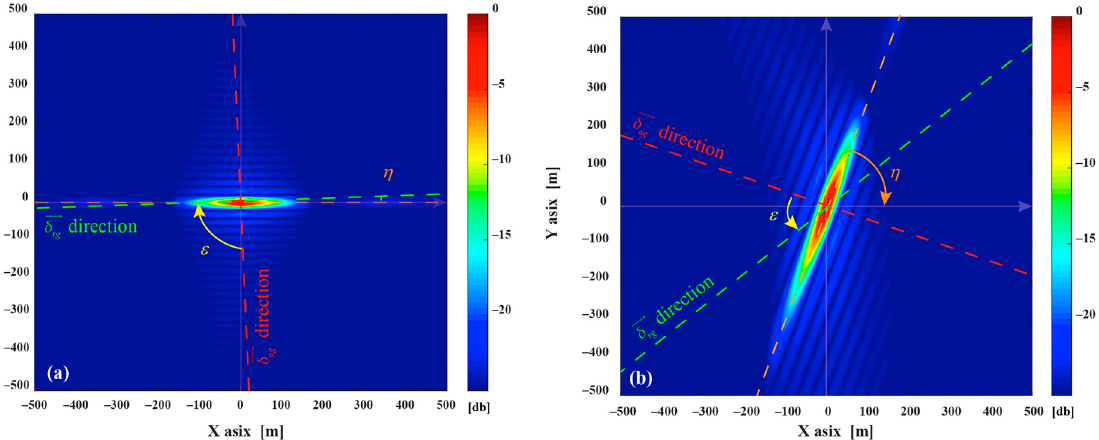
Figure 3. Simulated single-satellite Point Spread Function (PSFs), ( a ) is the PSF of A 1 ( 180 ◦ ,90 ◦ ,45 ◦ ) , ( b ) is the PSF of A 1 ( 150 ◦ ,60 ◦ ,45 ◦ ) .